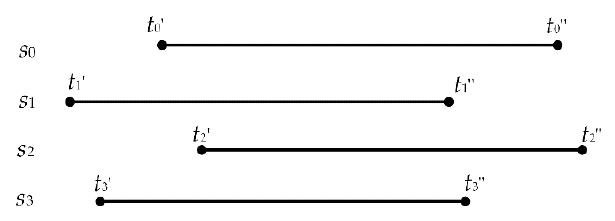
Figure 4. A group of signals produced by one bubble.